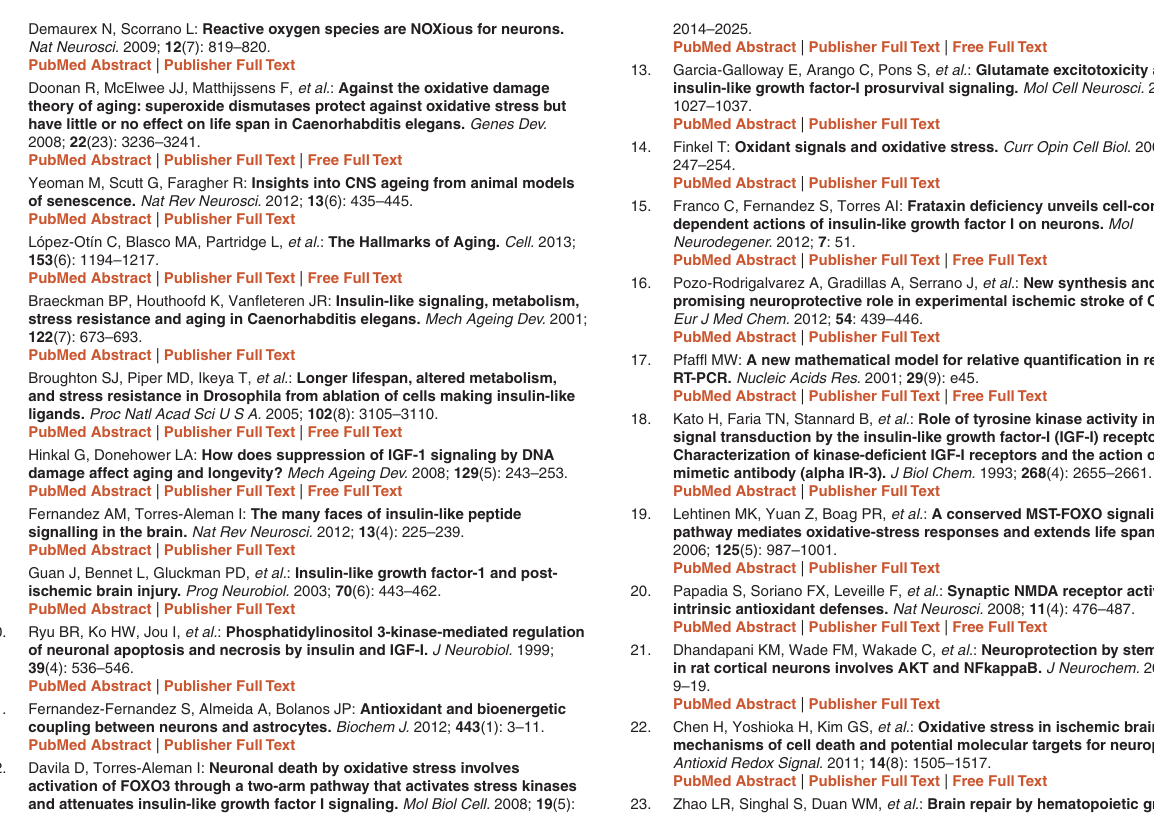
figshare: Update 1: Data on the responses of neurons and astrocytes to oxidative injury in the presence of insulin-like growth factor I, http://dx.doi.org/10.6084/m9.figshare.991456